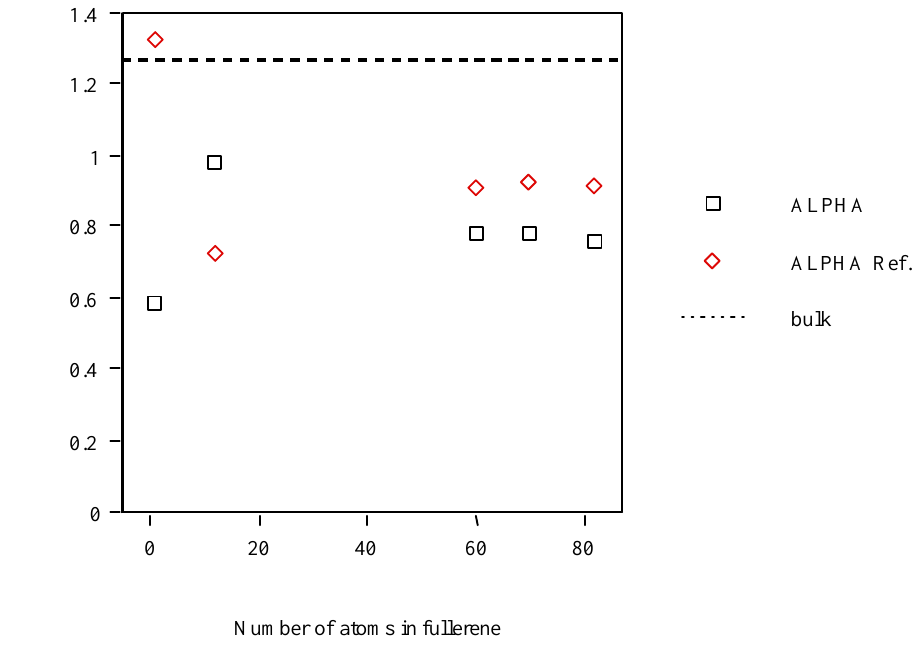
Figure 2. Average atom-atom polarizabilities per atom of fullerene models vs . cluster size. The polarizabilities < a > for the C one-shell graphite models are listed in Table 3. n Table 3. Elementary dipole-dipole polarizabilities for one-shell graphite